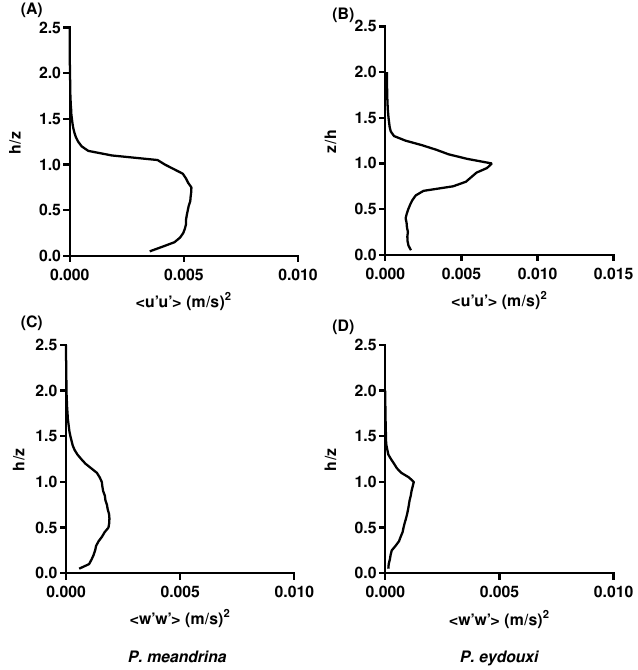
Figure 12. ( A , B ) streamwise, and ( C , D ), vertical velocity variance computed over P. meandrina and P. eydouxi , respectively. In both cases, the magnitude of the variance was found to be higher for P. meandrina where the inter-branch distance was smaller than for P. eydouxi